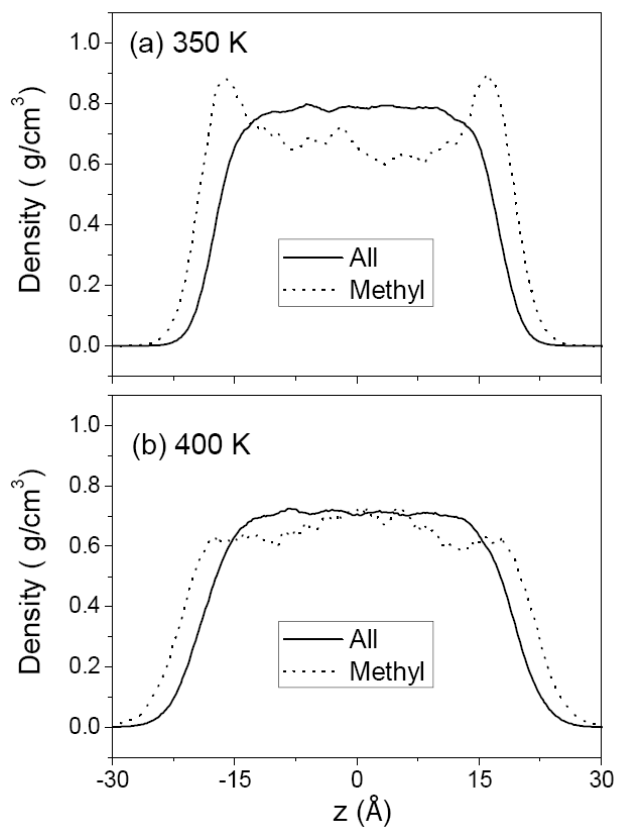
Figure 3. Density profiles of C 44 H 90 melt film obtained from MD simulation at 350 K ( a ) and 400 K ( b ), along the film thickness direction ( z ) with the film center at z = 0. The solid line is the density of all atoms, and the dotted line is the density of methyl groups. The latter is normalized to the former for comparison by taking into account the relative total populations.